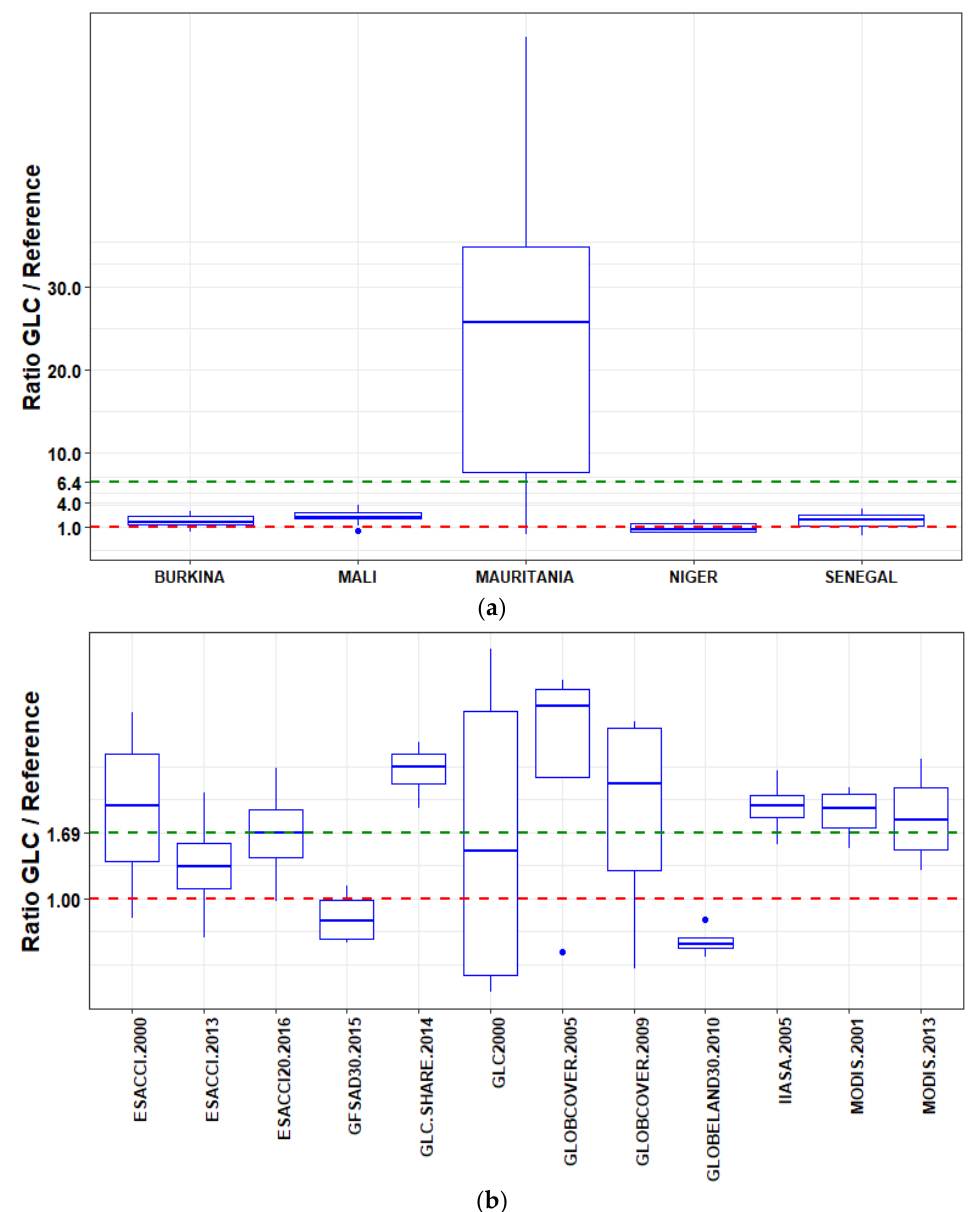
Figure 8. Ratio of mapped and reference crop areas. Aggregated by country ( a ), and by land cover products ( b ) with the ideal situation (ratio = 1) in red and the observed average ratio (1.69) in green.